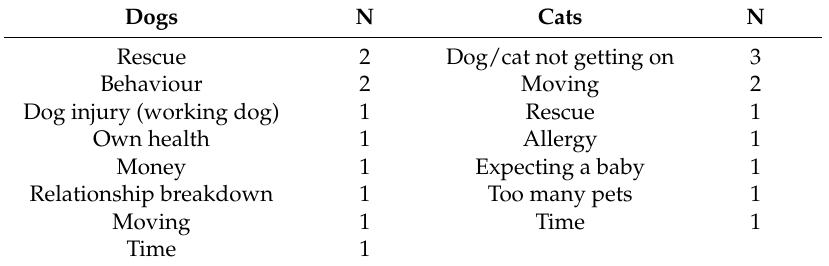
Table 8. Reasons for relinquishment given by dog and cat owners advertising their pet on Gumtree.